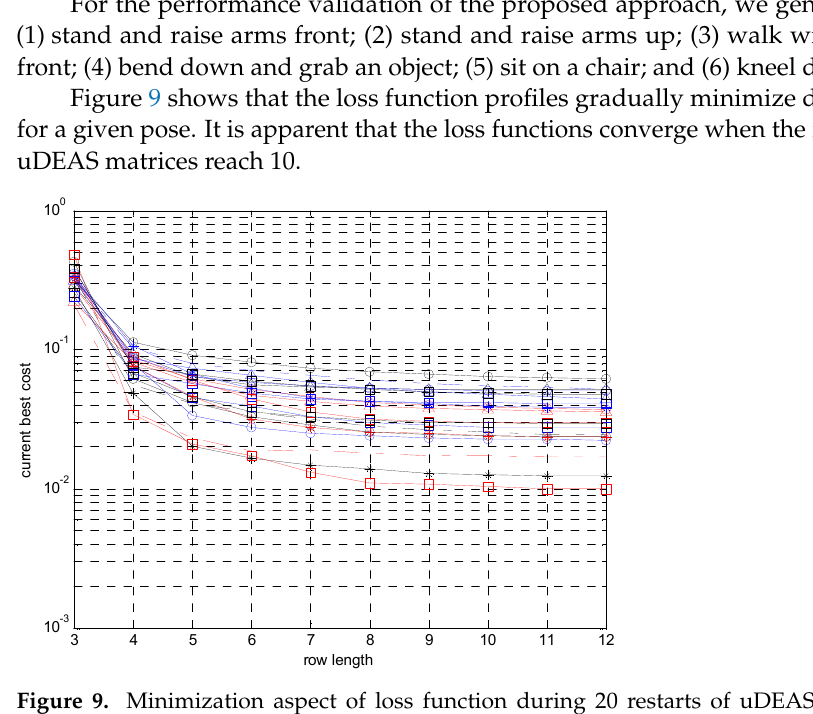
Figure 9. Minimization aspect of loss function during 20 restarts of uDEAS with each restart colored differently.